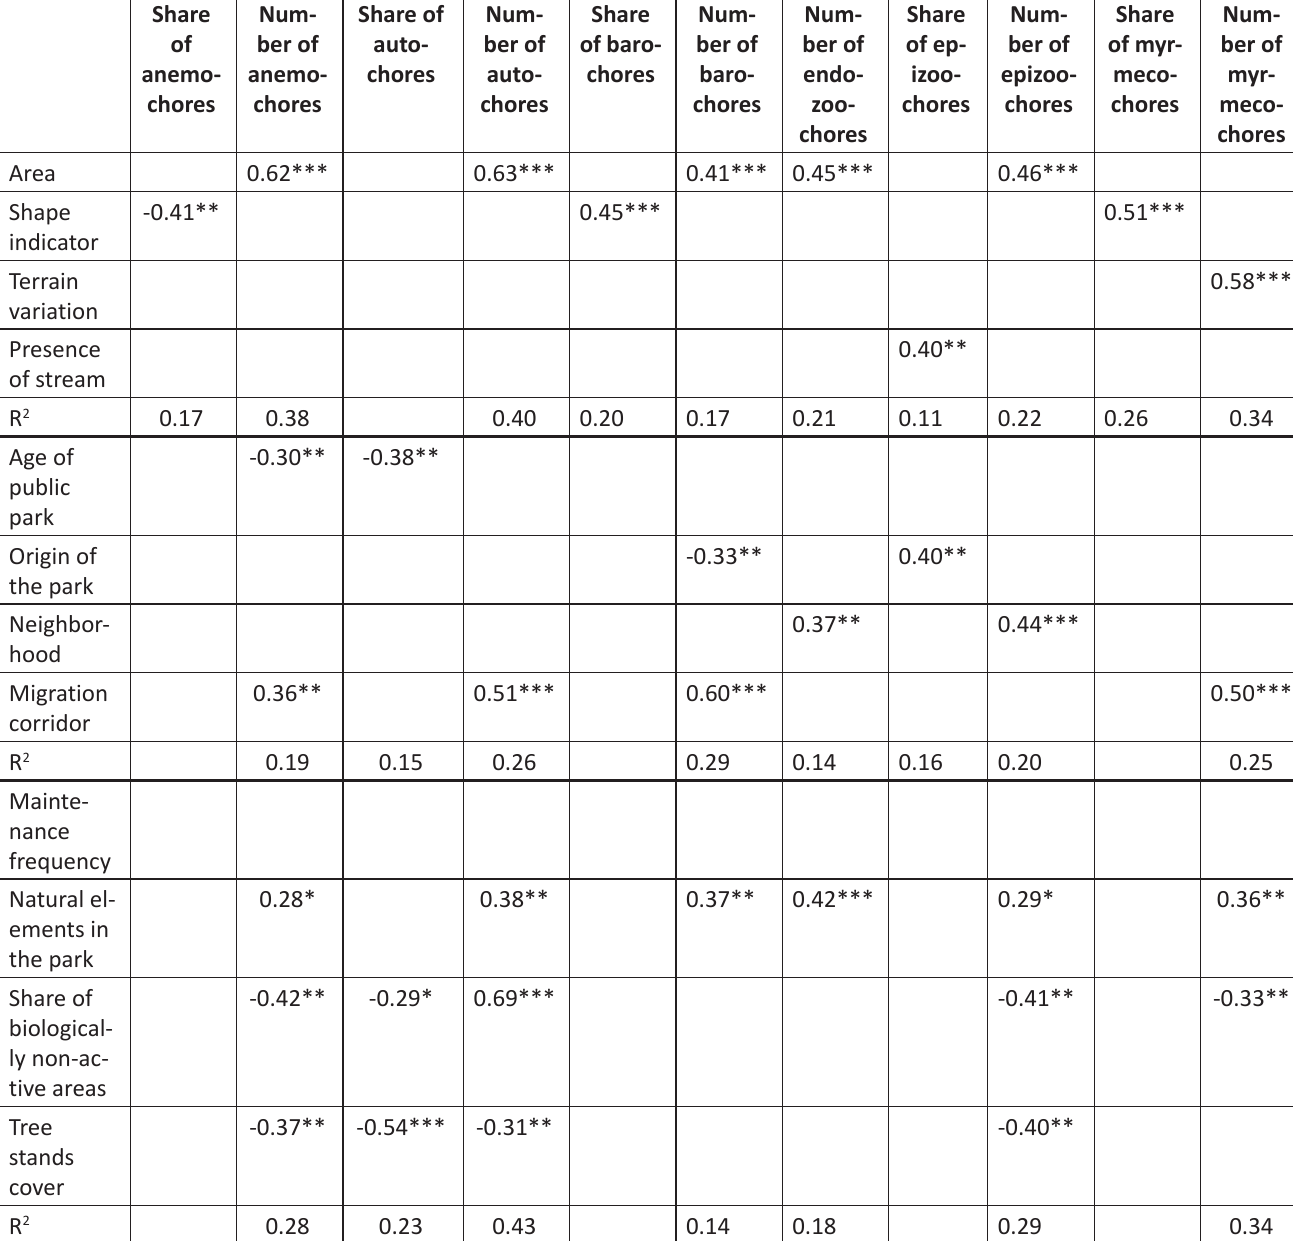
4. Regression coefficients of spreading types depending on selected park parameters in